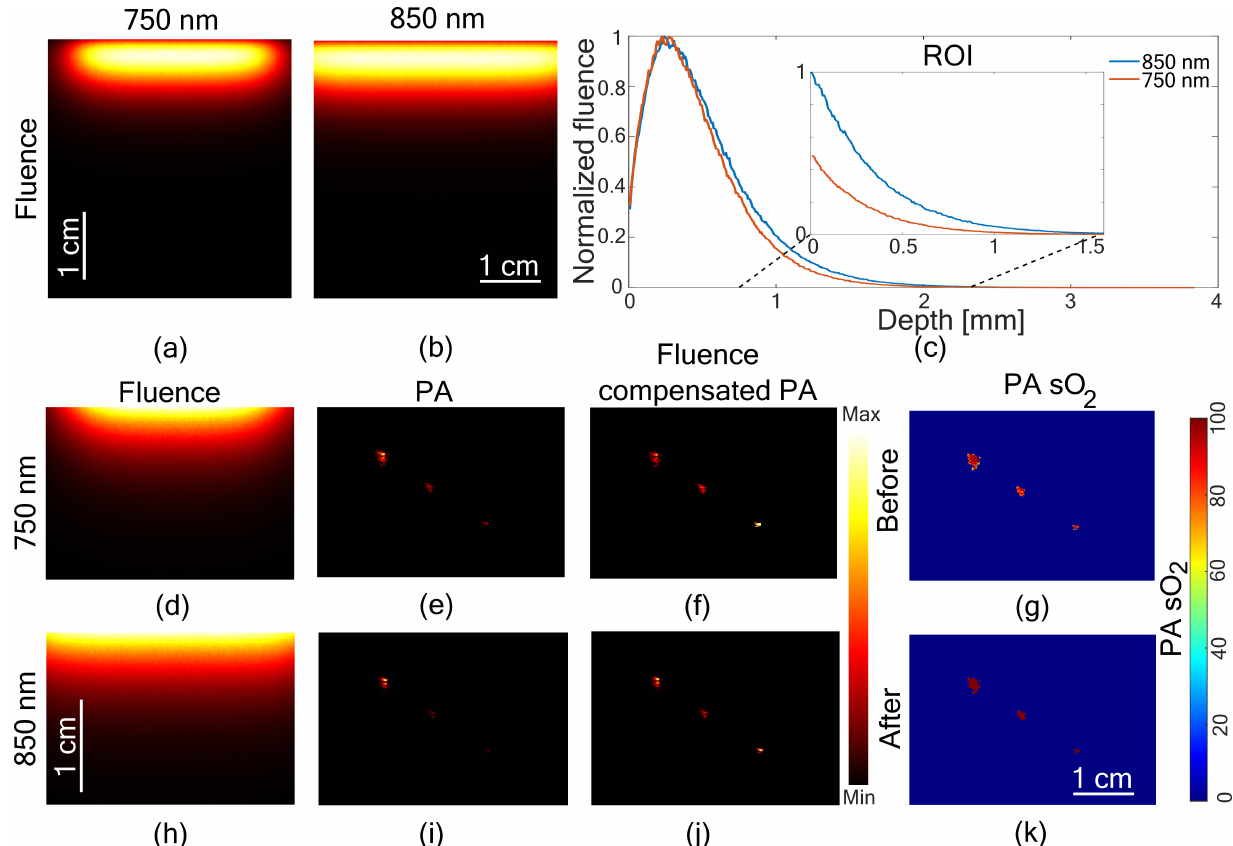
Figure 3. Fluence compensation in a homogeneous medium. Fluence map at the imaging plane from ( a ) 750 nm and ( b ) 850 nm. ( c ) Line profile showing normalized fluence in the depth direction and the zoomed-in region showing fluence decay in the Region Of Interest (ROI), marked with dashed lines. Fluence map in the ROI with ( d ) 750 nm and ( h ) 850 nm. Uncompensated photoacoustic (PA) images at ( e ) 750 nm and ( i ) 850 nm and corresponding fluence compensated PA images ( f , j ). Photoacoustic oxygen saturation images (PA sO 2 ) ( g ) before fluence compensation and ( k ) after fluence